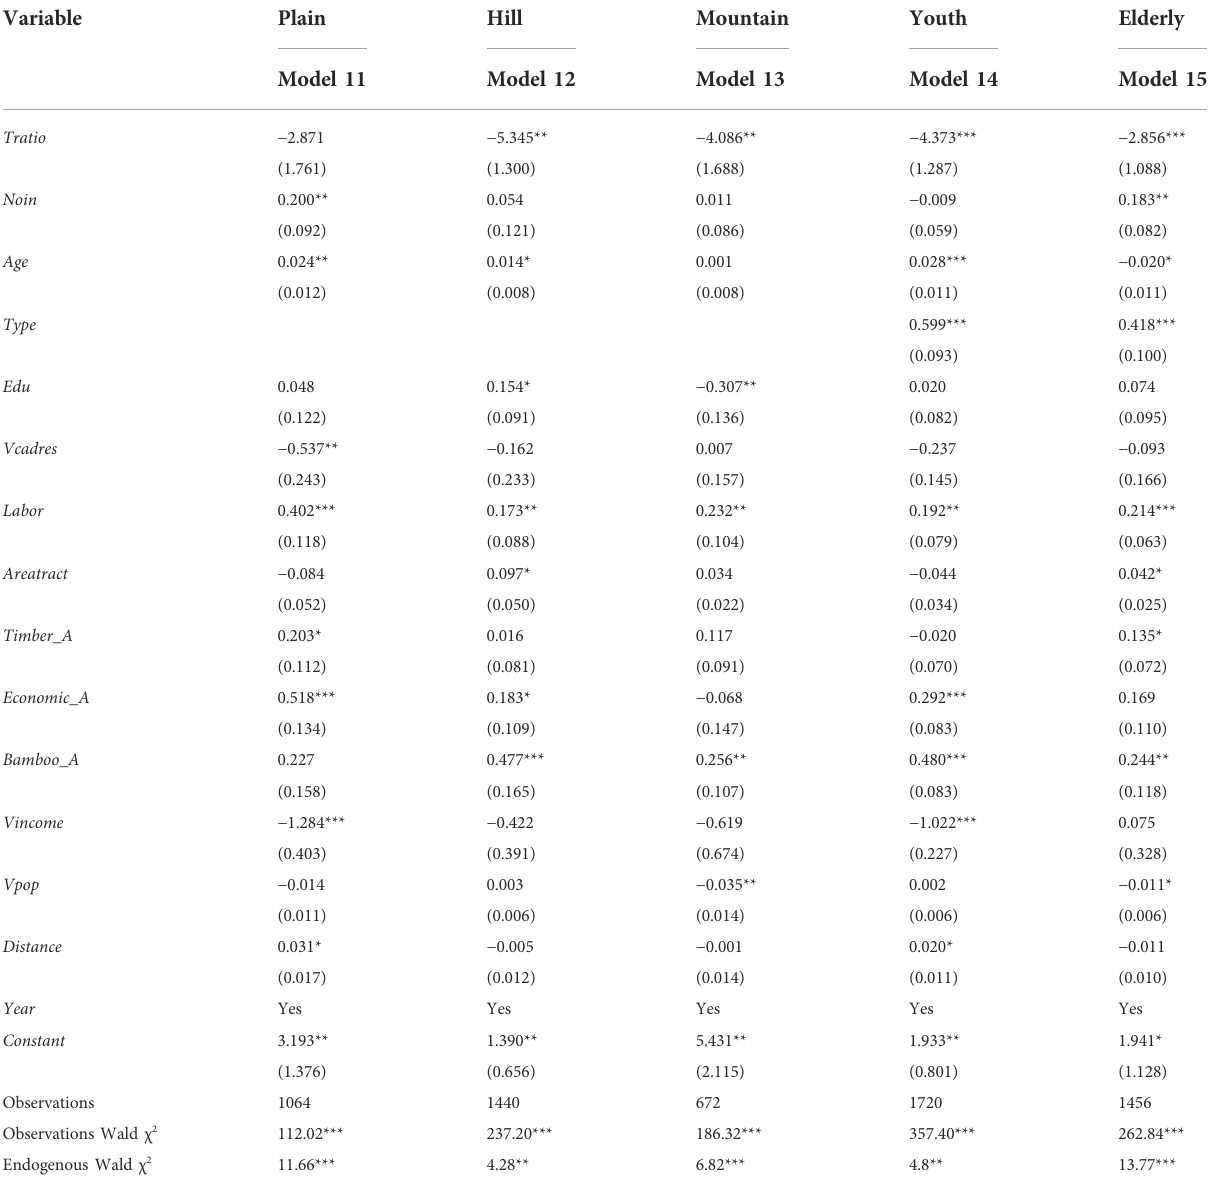
TABLE 4 Heterogeneity analysis of the village types and ages for labor migration.